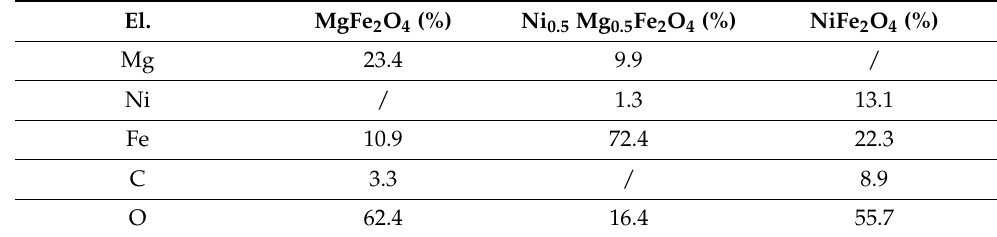
Table 2. Quantitative surface elemental analysis obtained by X-ray photoelectron spectroscopy. El.